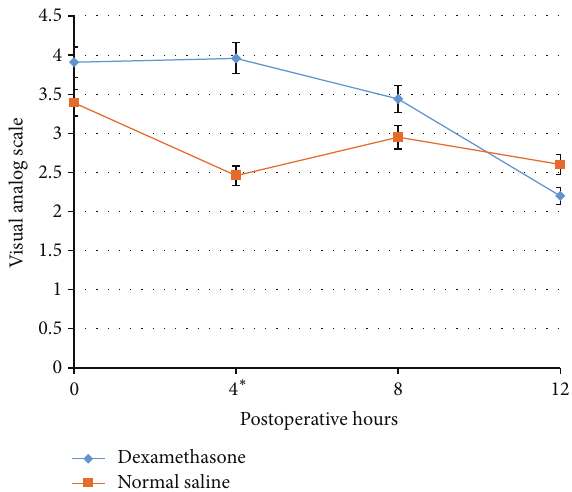
Table 4: Total number of codeine tablets taken during the first 48 h